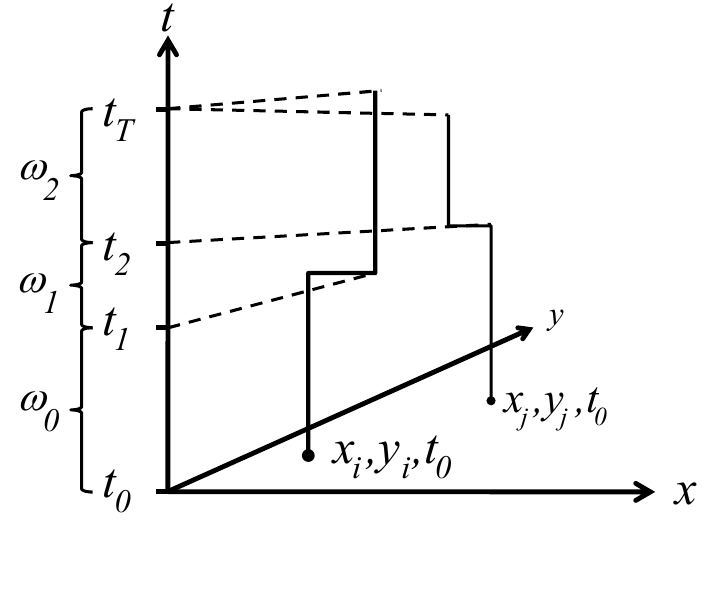
Figure 1. Residential histories as space-time step functions. The axes x and y define a geographic domain ( i.e. , longitude and latitude decimal degrees), the t axes represents time ( i.e. , date). The study extends from time (cid:1872) to time (cid:1872) . The residential histories for persons (cid:2868) (cid:3021) i and j are shown as step functions through space-time. For example, person i begins the . They remain at that geographic coordinate until the study residing at location (cid:1876) , (cid:1877) , (cid:1872) (cid:3036) (cid:3036) (cid:2868) instant before time (cid:1872) , when they move to (cid:1876) . The duration of time they reside at this , (cid:1877) , (cid:1872) (cid:2869) (cid:3036) (cid:3036) (cid:2869) first place of residence is (cid:2033) (cid:2868)